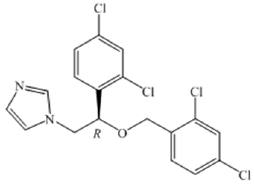
Figure 1. Structure of R -Miconazole.